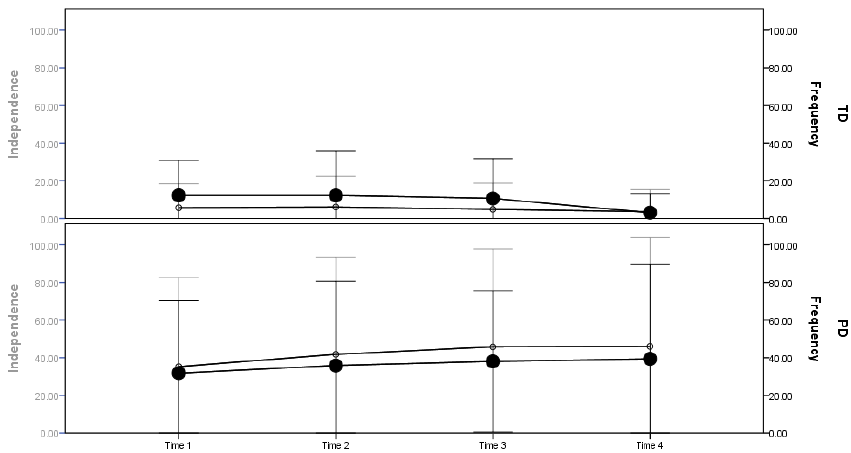
Figure 1. Independence and frequency of attendance gap by groups (TD vs. PD) across the four time points. Note: Dark point ( • ) and black line with 1 SD error bar illustrate the frequency of attendance scores; open circle point ( ○ ) and gray line with 1 SD error bar illustrate the independence scores.